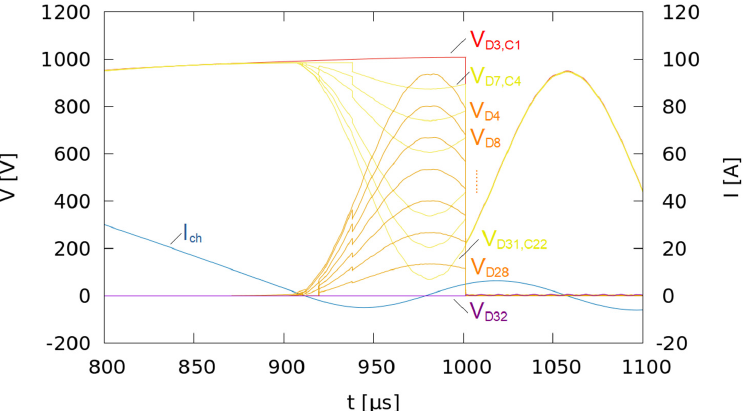
Figure 6. Simulated voltages at the charging path referenced to the negative poles of the stage capacitors for the 8-stage Marx generator according to Figure 3. The voltages at each stage across the series connection of the diode between the positive charging path and stage and the stage capacitor are marked as V D3,C1 for the leftmost stage and V D7,C4 … V D31,C22 for the other stages in the order from left to right. The voltages across the diodes to the negative charging path are named according to the respective diodes (V D4 , V D8 … V D32 ). The curve named I Ch shows the charging current at the generator’s charging input.